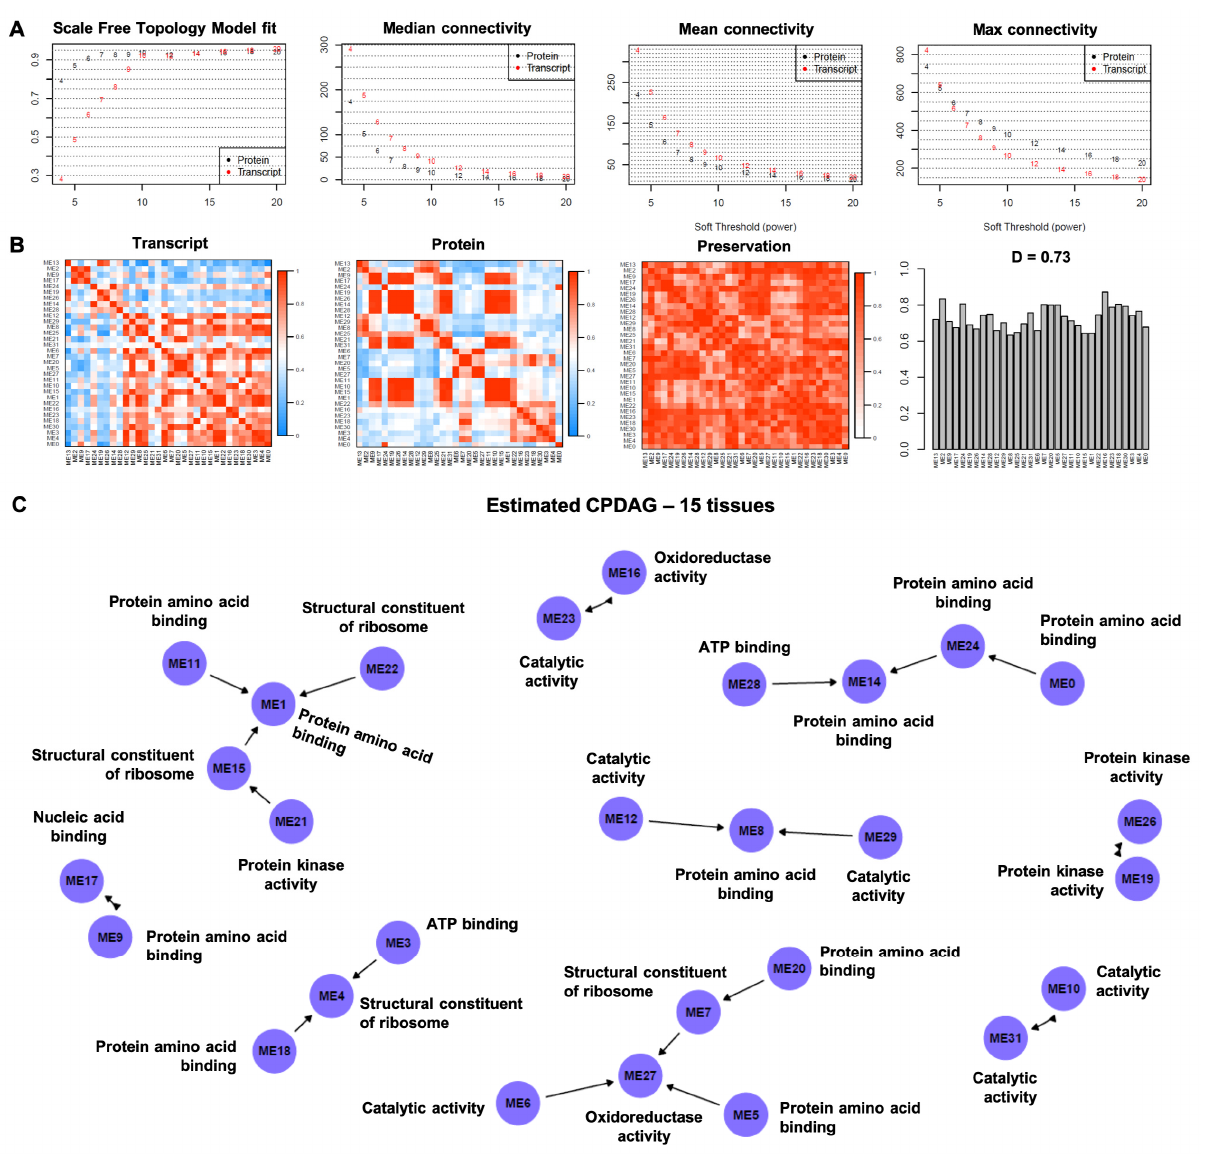
Figure 2. ( A ). Summary network indices are displayed as functions of the soft threshold power. The plots indicate that approximate scale-free topology is achieved around the soft-threshold power of 9. ( B ). Consensus eigengene networks are displayed and their differential analysis, based on all the 15 tissues considered (leaves, shoot, bud, flowers, stem/pedicle, and fruit). The first two plots show the eigengene network heatmaps in the proteomic and transcriptomic datasets (labeled Transcript and Protein). In the heatmaps, the red color represents high adjacency between modules (i.e., positive correlation), and the blue color denotes low adjacency (i.e., negative correlation) between the corresponding modules. The preservation heatmap (3rd plot) shows the preservation network, defined as one minus the absolute difference of the two eigengene networks. The barplot (4th plot) shows the mean preservation of adjacency for each of the eigengenes to all other eigengenes (column means of the preservation heatmap). ( C ). The completed partially directed acyclic graph (CPDAG) is displayed. Both directed and bidirected edges are present in the causal graph. The description corresponding to the modules is based on the most frequent gene ontology term, observed within each